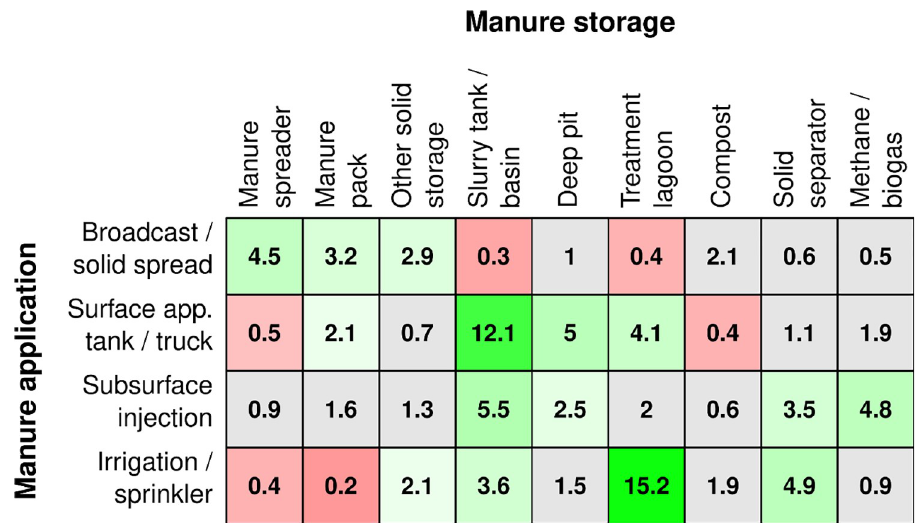
Fig 7. Relationship of manure application to manure storage. Results of logit models taking each storage method as the independent variable, and each application method as the dependent variable. Odds ratios (OR) from each of the logit models are given, with red shading indicating an OR < 1, and green an OR > 1. Models in which the association did not achieve significance at the family-wise p < 0.05 level across rows are color coded grey.